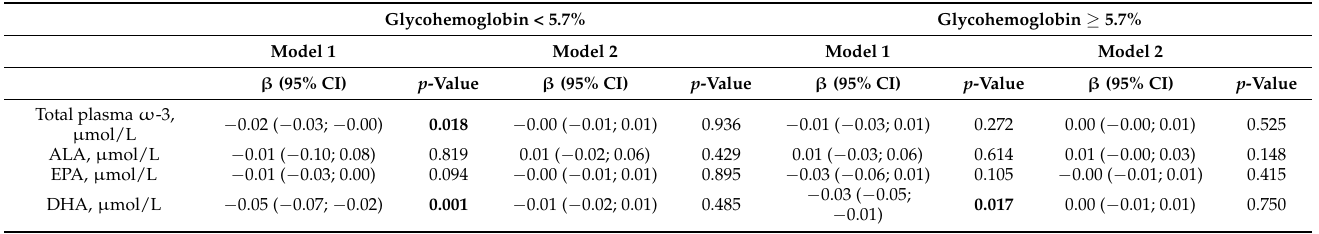
Table 3. Linear regression of plasma omega-3 levels and handgrip strength in individuals with elevated and normal glycohemoglobin. NHANES,